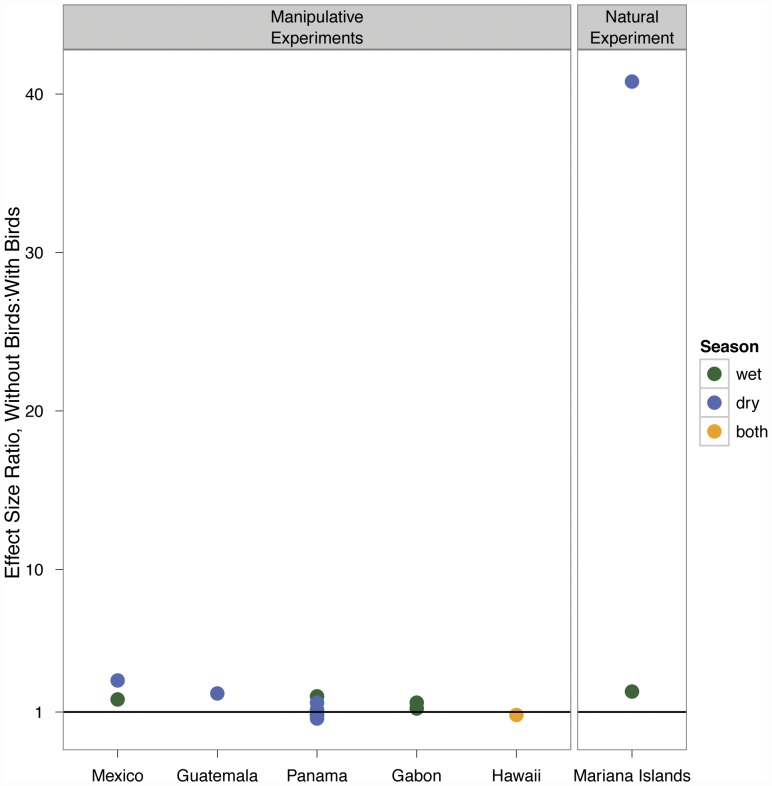
Difference in effect size between manipulative and natural experiments.The effect sizes from manipulative experiments in the tropics included in a recent review paper [16] range from no effect to a 3-fold effect, much less than the effect seen in the dry season during the natural experiment in the Mariana Islands.